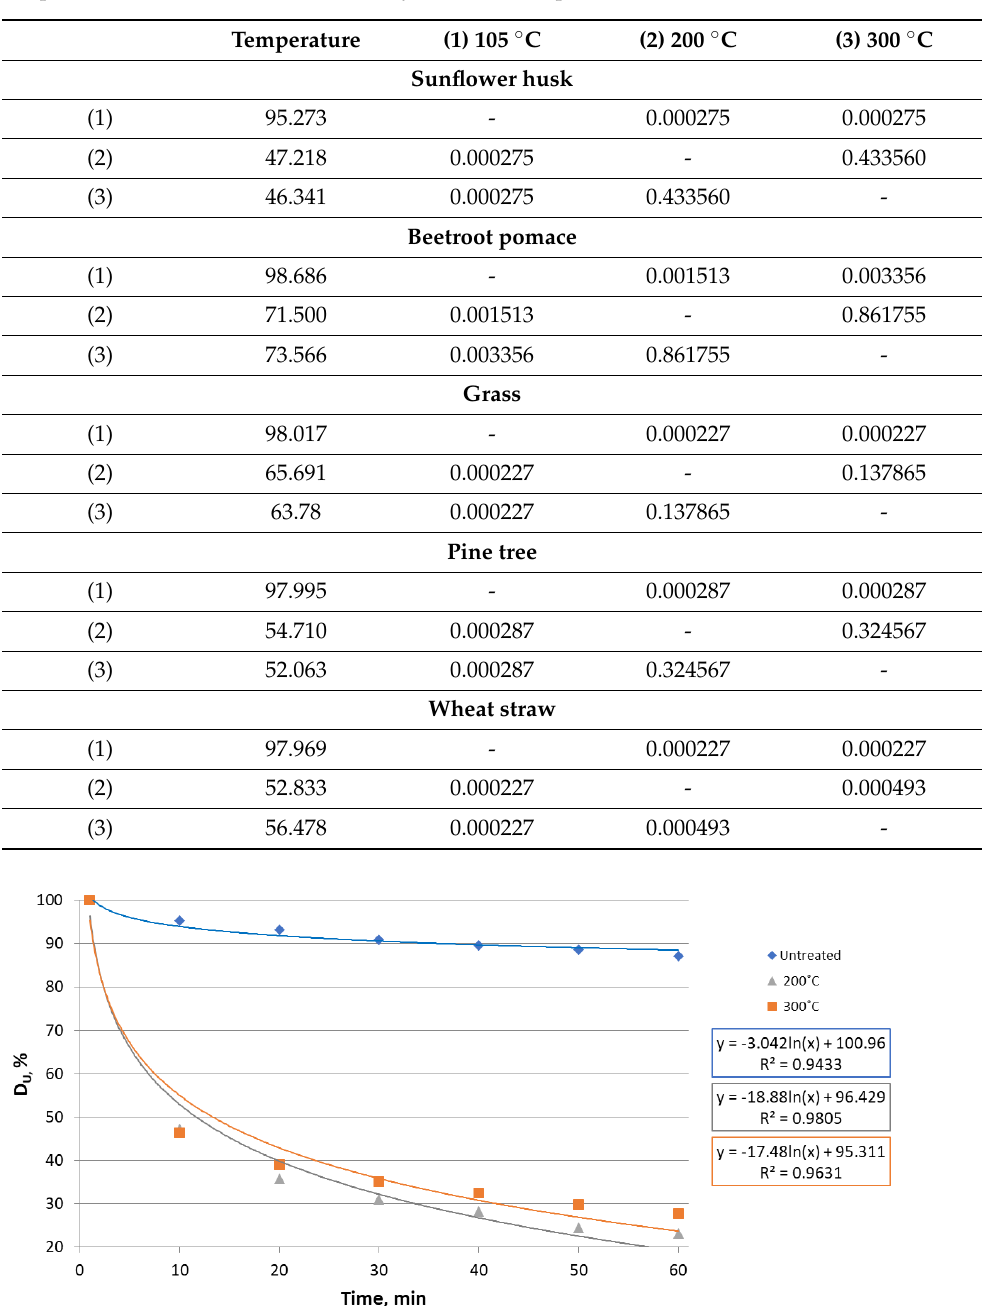
Figure 6. Mechanical durability of untreated and torrefied beetroot pomace pellets. Figure 7. Mechanical durability of untreated and torrefied grass pellets.